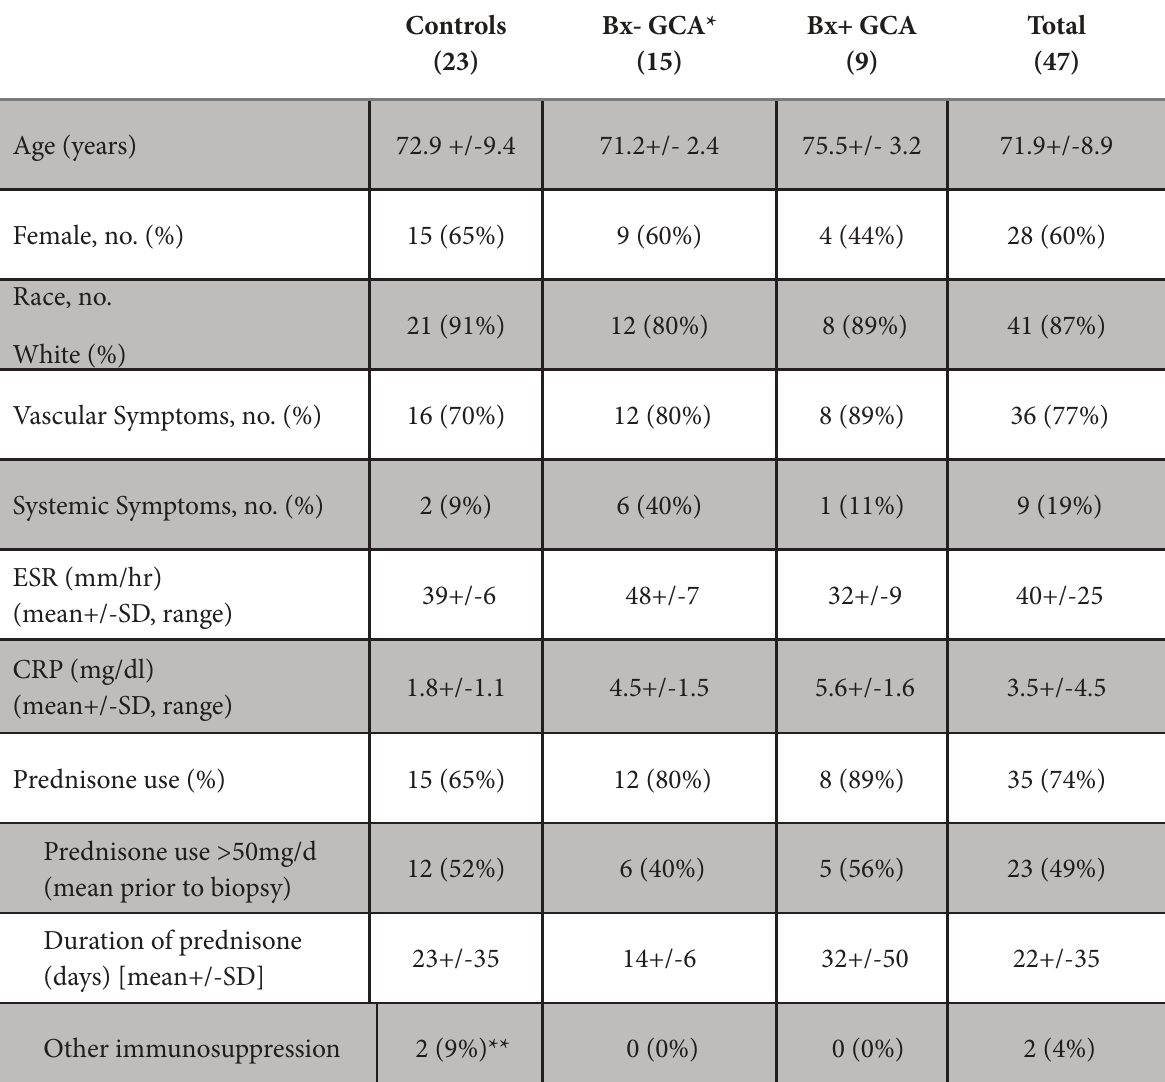
Table 1 . Patient baseline demographics at the time of